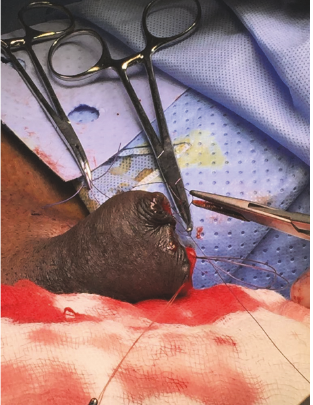
Figure 1: Preoperative appearance of the penis.